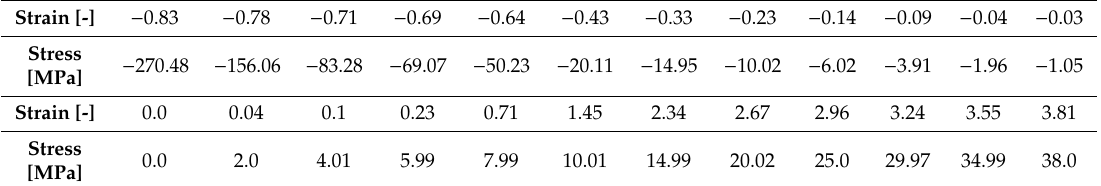
Table 5. Adopted TPU 95 Polyflex stress–strain characteristics.